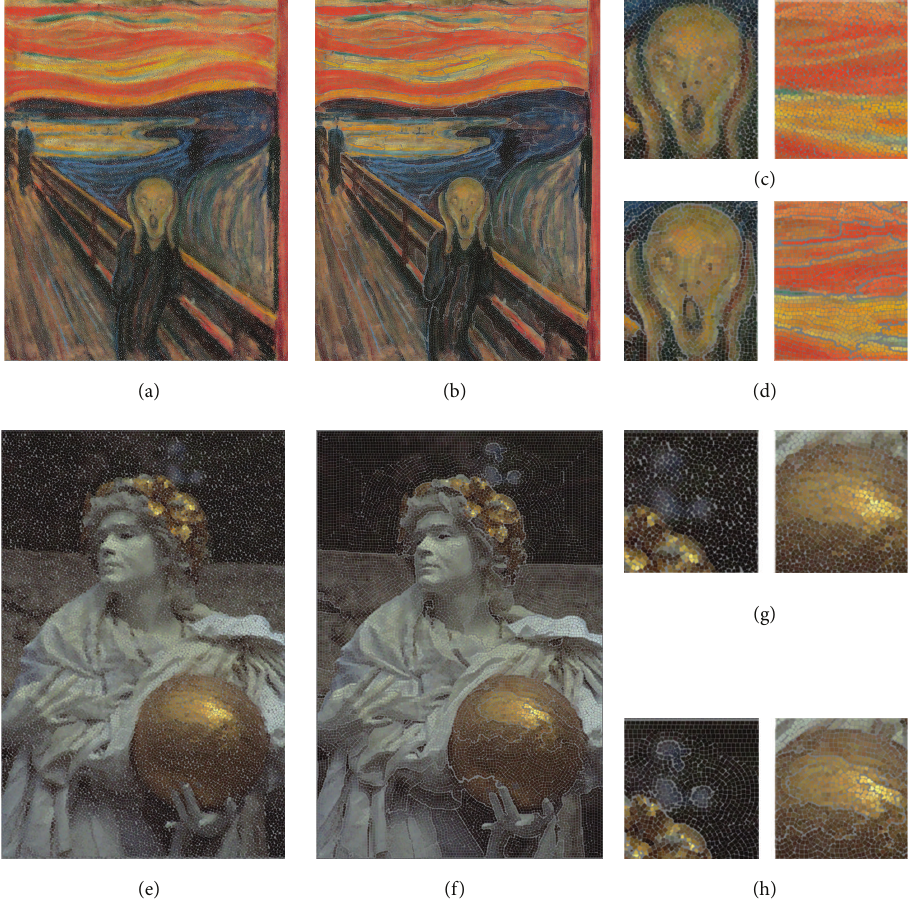
Figure 14: Visual comparisons of artificial mosaic techniques—our approach on the left (a, c, e, g) and Di Blasi and Gallo [22] on the right (b, d, f,